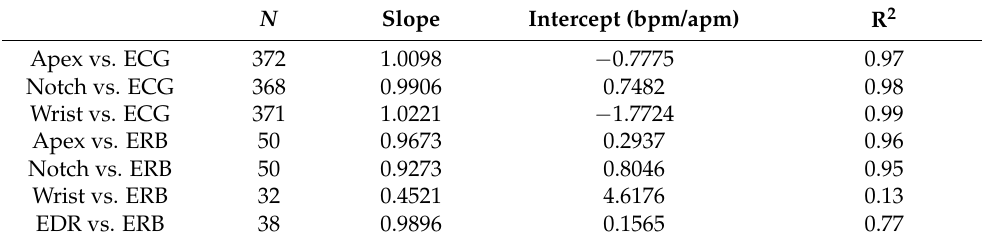
Table 2. Results of correlation analysis for instantaneous heart and respiratory